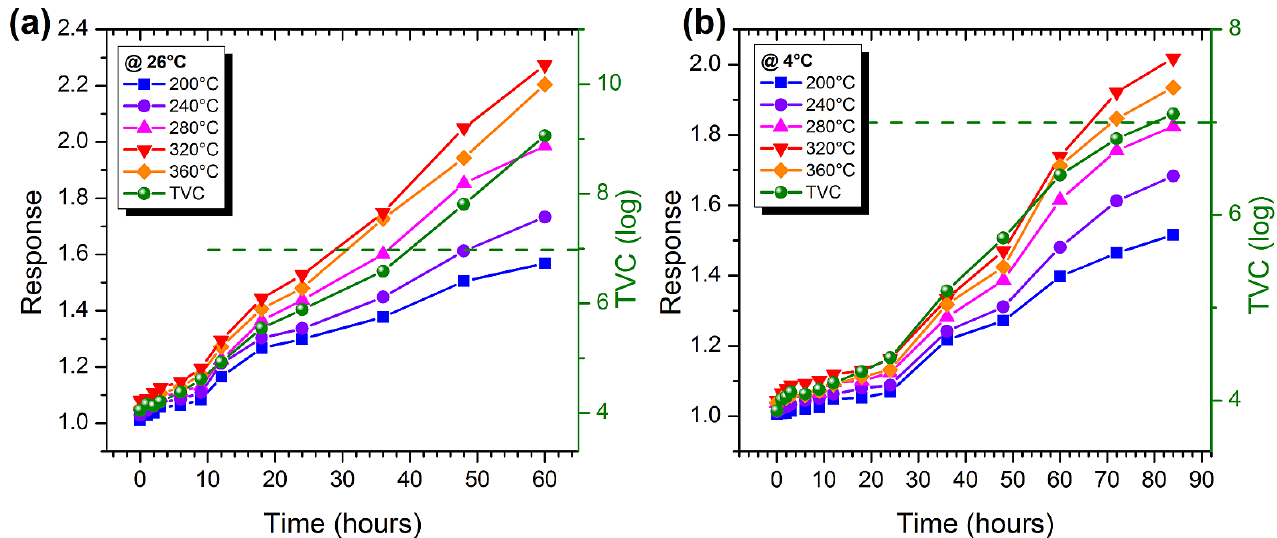
Figure 5. ( a ) Sensor response (colored symbols, left scale) and bacterial population (green spheres, right scale) in pork samples stored at room temperature over a period of 60 h; ( b ) sensor response (colored symbols, left scale) and bacterial population (green spheres, right scale) in fresh marble trout stored at in a refrigerator over a period of 84 h. Figure 5b shows the resistive sensor response and TVC of pork samples stored in a refrigerator at 4° C. The slope of the curves is low up to about 24 h and then increases, and the microbial count reaches the threshold after about 80 h.